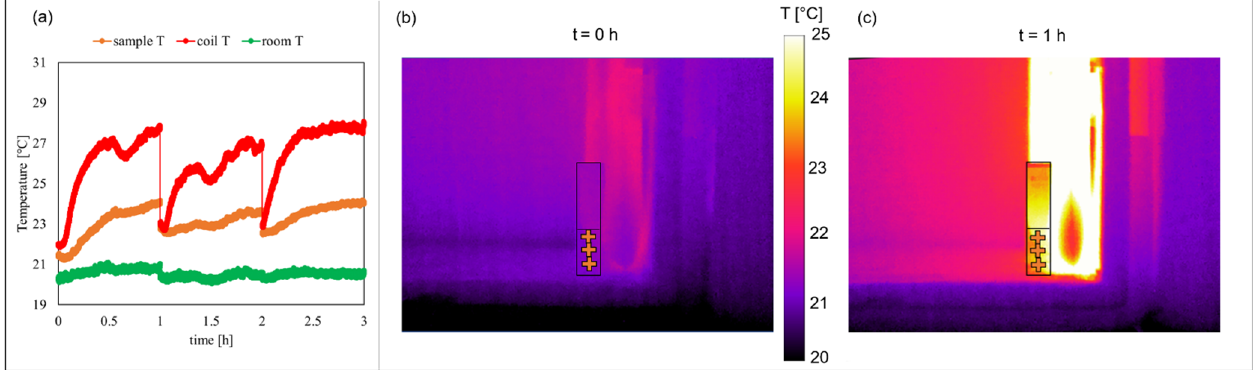
Figure 3 . Temperature characterization outcomes. ( a ) Temperature profile in time of the sample (orange curve), the coil (red curve) and the room environment (green curve). Thermographic images of the experimental bench recorded during the PEMFs exposure at t = 0 h ( b ) and t = 1 h ( c ). Selected cursors on the sample are reported as orange crosses.